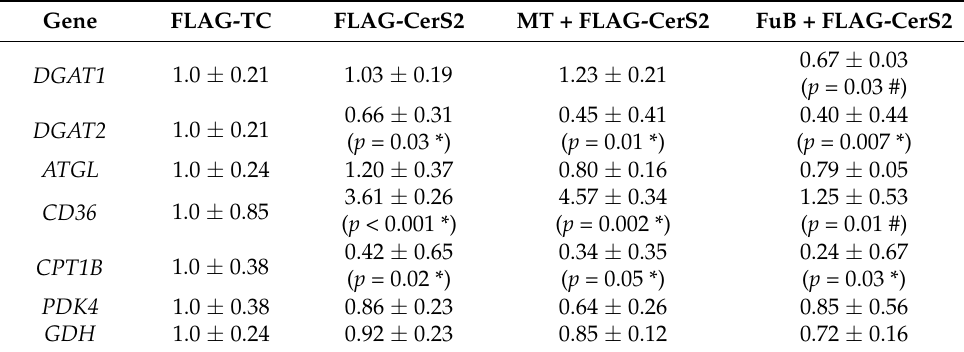
Table 8. Metabolism related mRNA expression in transfected